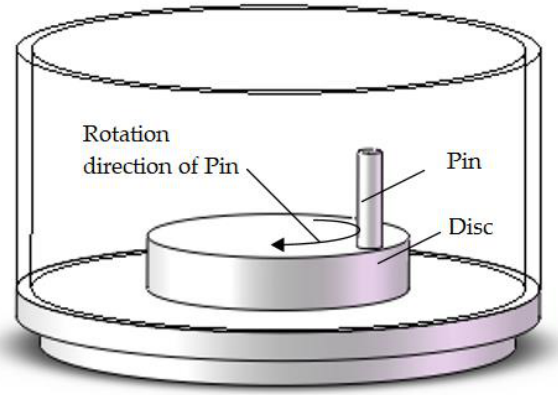
Figure 1. The schematic drawing of the pin-on-disc. The pin specimens were manufactured using same materials as the peanut spring- finger: 65Mn steel. The pin and disc geometry are shown in Figure 3. The material of the disc is 45 steel. The surface roughness of samples is Ra6.3. The pin had a diameter of 5 mm and a length of 20 mm, and the diameter and the thickness of the disc were 55 mm and 11 mm, respectively. The pin and disk surfaces were cleaned using acetone and alcohol to avoid non-desirable films such as grease on the surface. The rhizomes of peanut are easily entangled with soil debris when the peanut spring- finger was working. The tensile strength of rhizomes of peanut is about 8 N. The actual speed range of the spring-finger is 0.8–1.8 m/s. In order to simulate the working conditions of the peanut spring-finger as much as possible, the wear tests were carried out under loads of 2, 5 and 8 N; sliding velocities of 300 r/min (0.82 m/s), 450 r/min (1.22 m/s) and 600 r/min (1.63 m/s); soil types of sandy soil, loam and clay; and soil moisture (the percentage of water mass in total mass) of 0, 10% and 20% [4,9]. The tests were maintained until the revolutions of 12,250 (the peanut harvester worked the distance of 3000